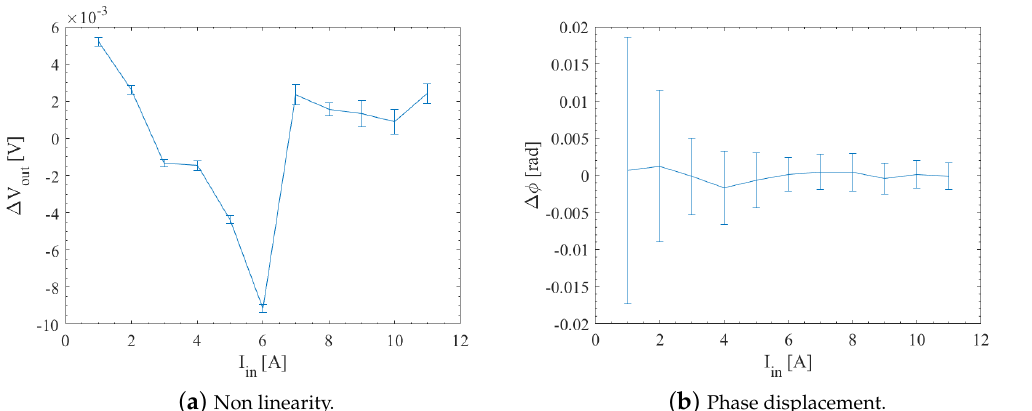
( a ) Non linearity. ( b ) Phase displacement. Figure 7. Performance parameters of the adopted current sensor. Table 2. Performance factors evaluated on a set of 10 current